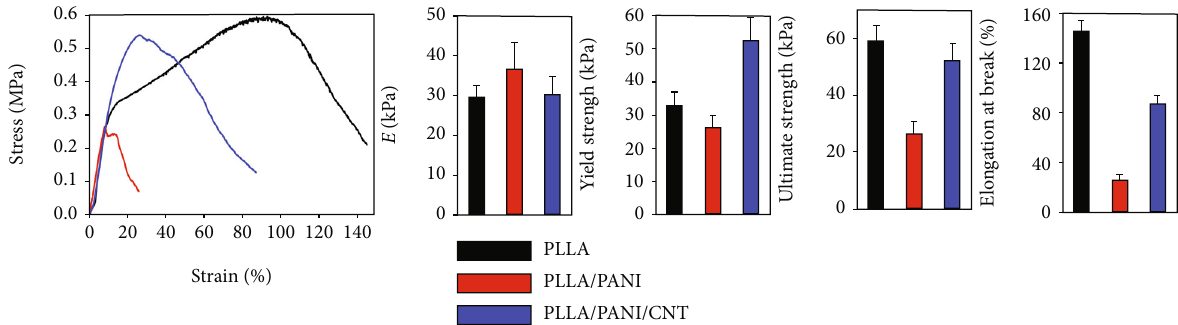
Figure 3: Stress-strain curves for PLLA (in Black), PLLA/PANI (in red) and PLLA/PANI/CNT (in blue). Elastic modulus, E , yield strength, ultimate strength, and elongation at break were calculated for mentioned samples. Black: PLLA, red: PLLA/PANI, and blue: PLLA/PANI/ CNT samples. The presented data are expressed as mean ± SD ( n = 3